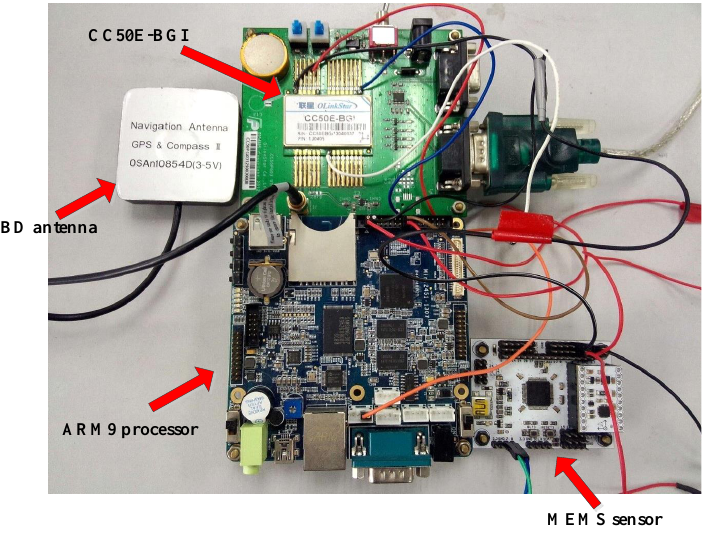
Figure 8. Hardware platform.